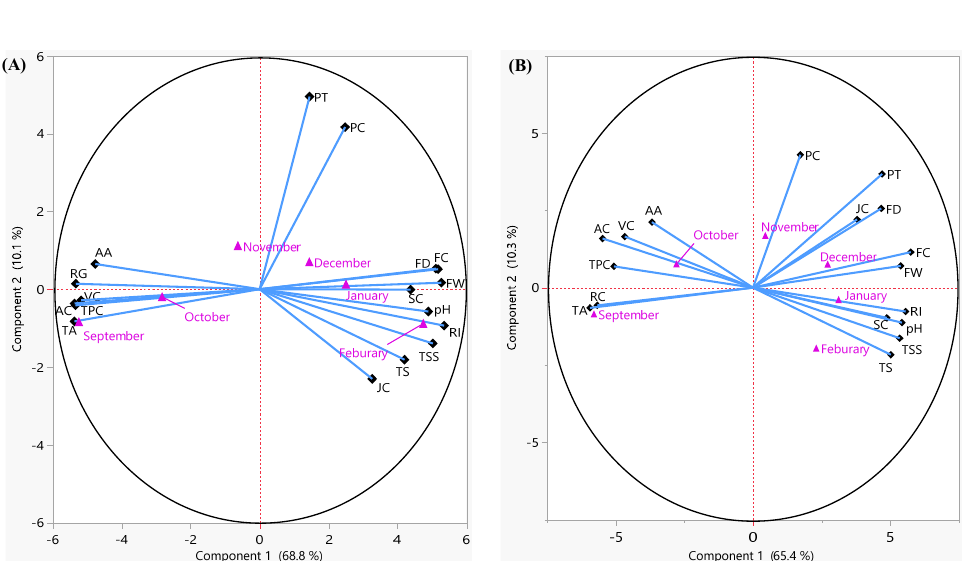
Figure 6. The biplots of the PCA describing the segregation of fruit quality characters of Kinnow ( A ) and Feutrell’s Early ( B ) harvested from September to February. Parameter codes: FW—fresh weight,